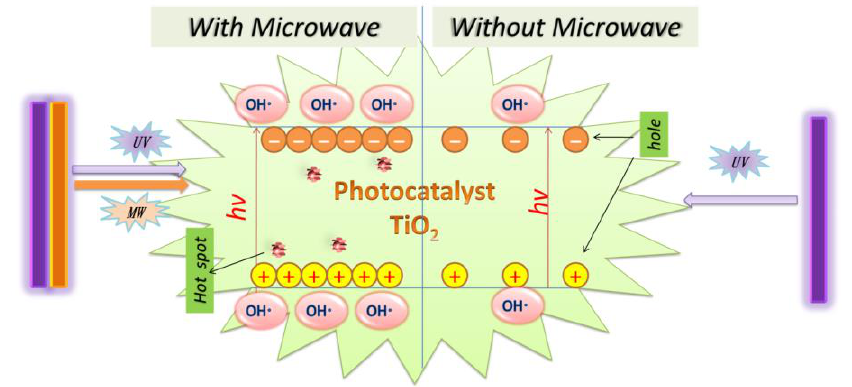
Figure 4. The role of microwave in MW/UV/TiO 2 photocatalytic technology.